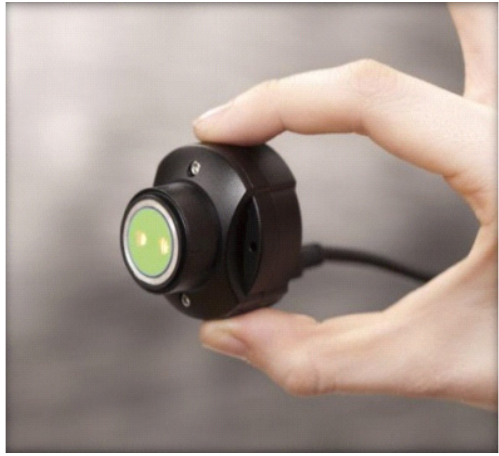
Fig. 1. Micro NIR 1700